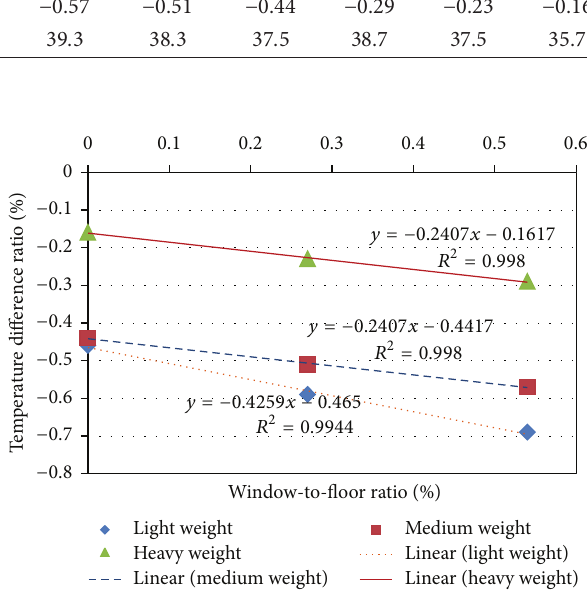
Figure 5: TDR as a function of the window-to-floor